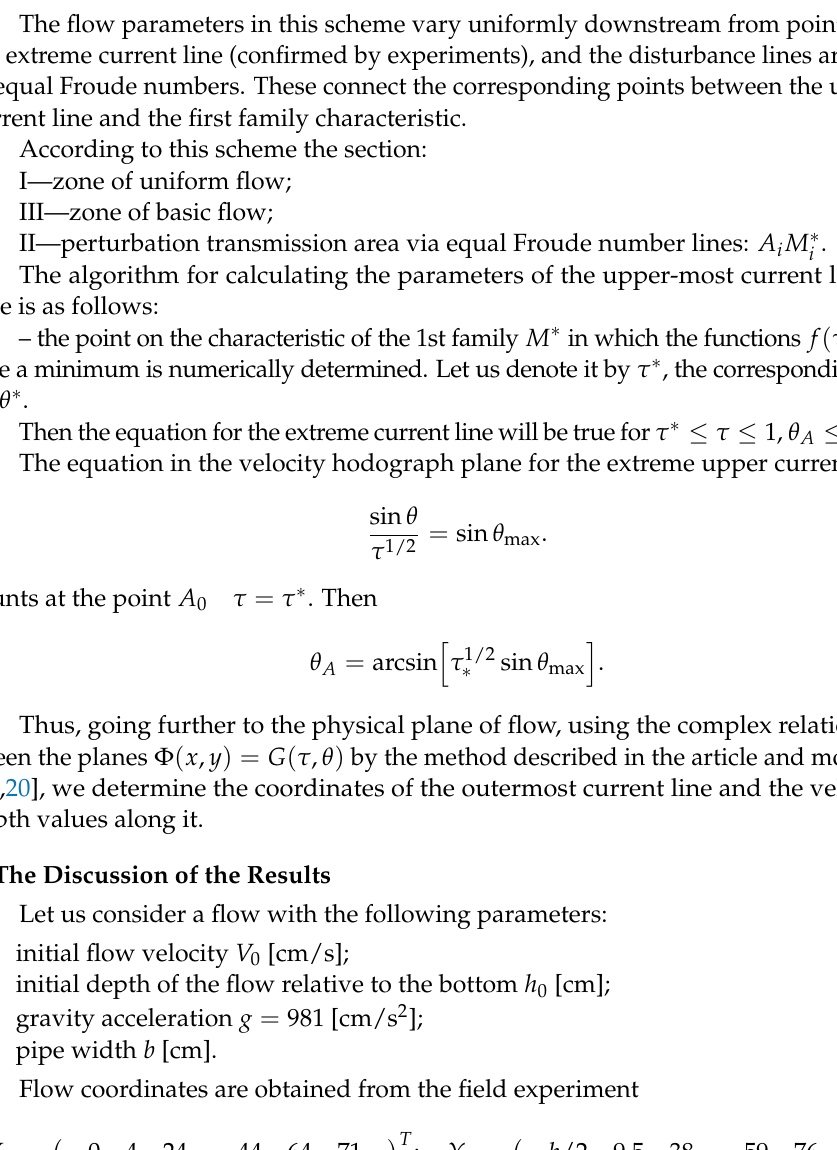
Figure 6. Schematic for calculating the flow parameters.